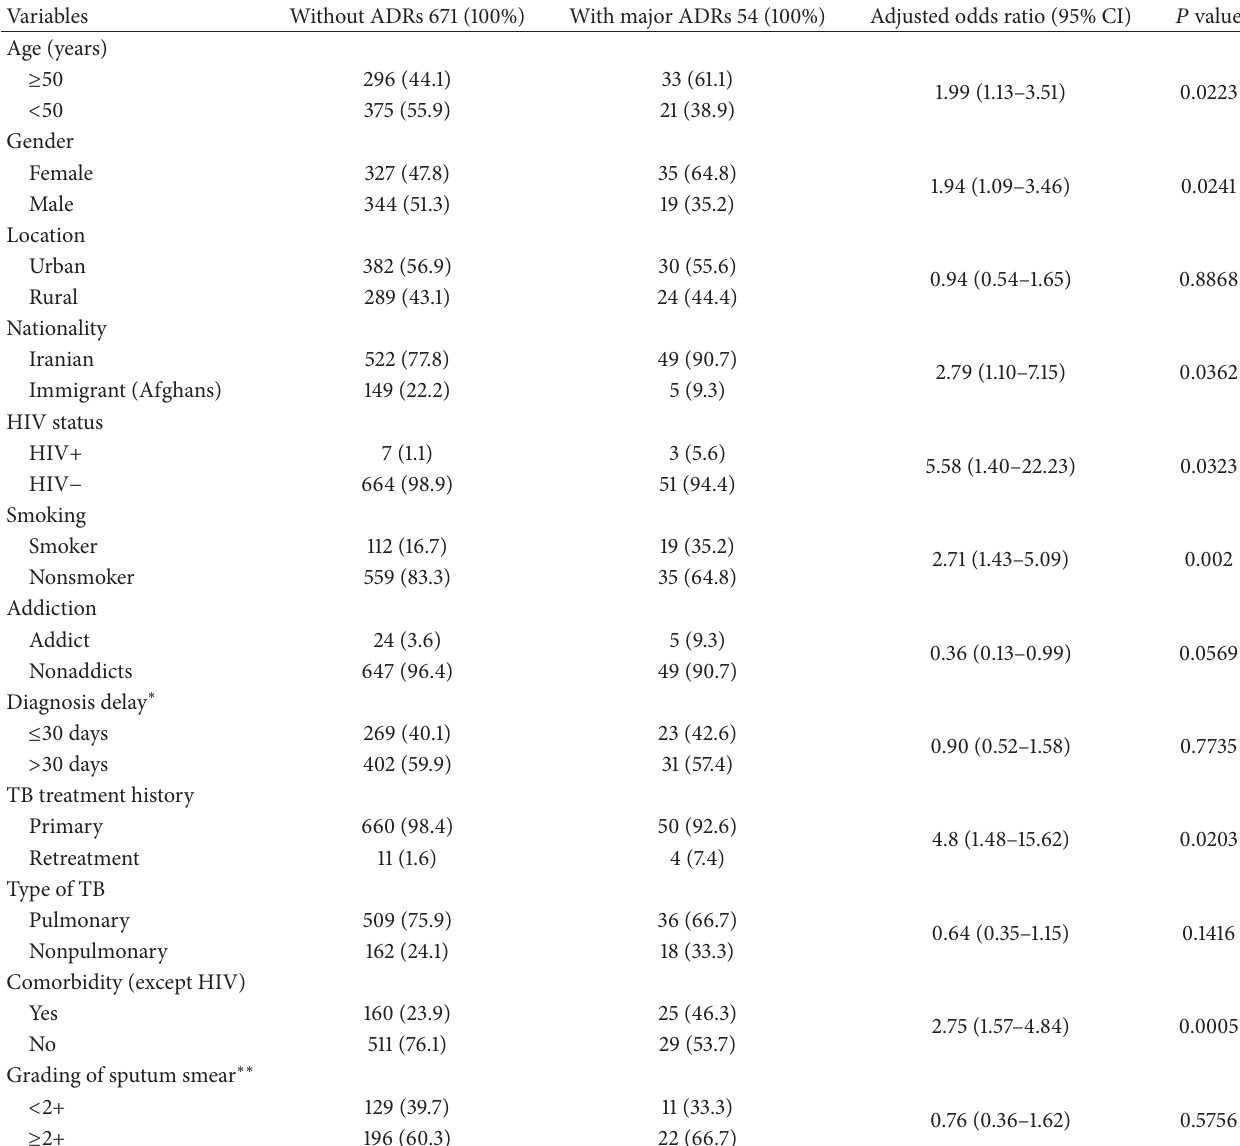
Table 2: Associated risk factors for major adverse drug reactions due to anti-TB